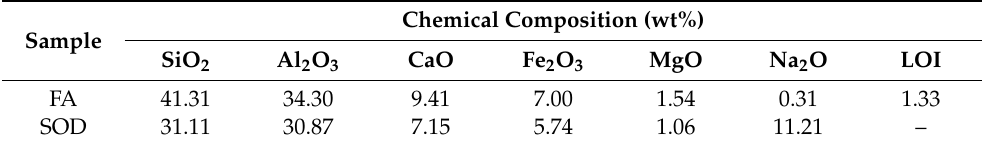
Table 1. Chemical constituent of FA and SOD